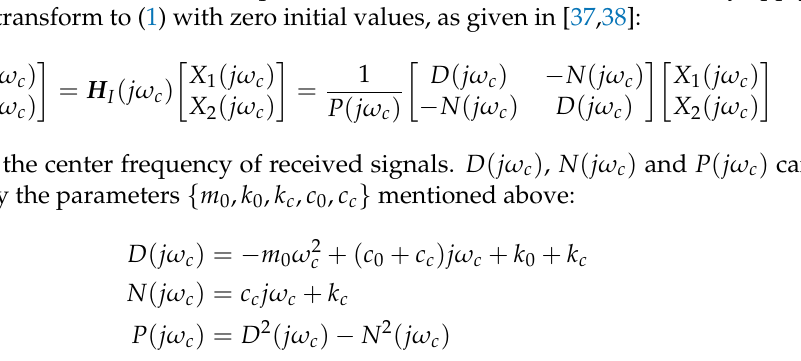
Figure 1. Photograph of the Ormia’s auditory system and its correspondence relationship with the mechanical model. It consists of springs and dash-pots, which reflects the tympanic membrane and the coupled